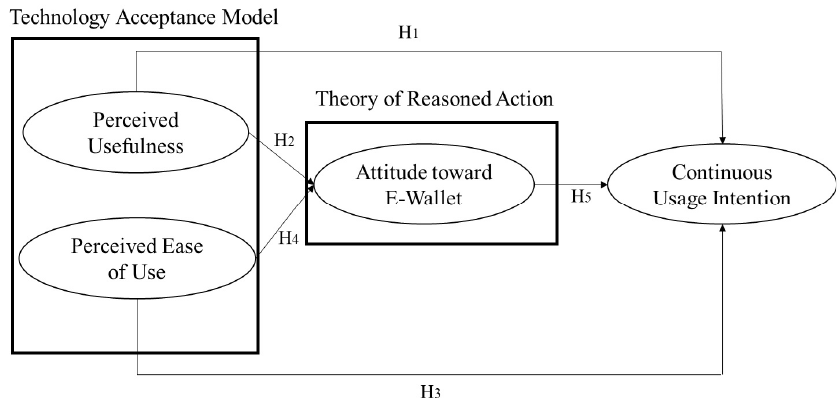
Fig. 1. The structure of the proposed